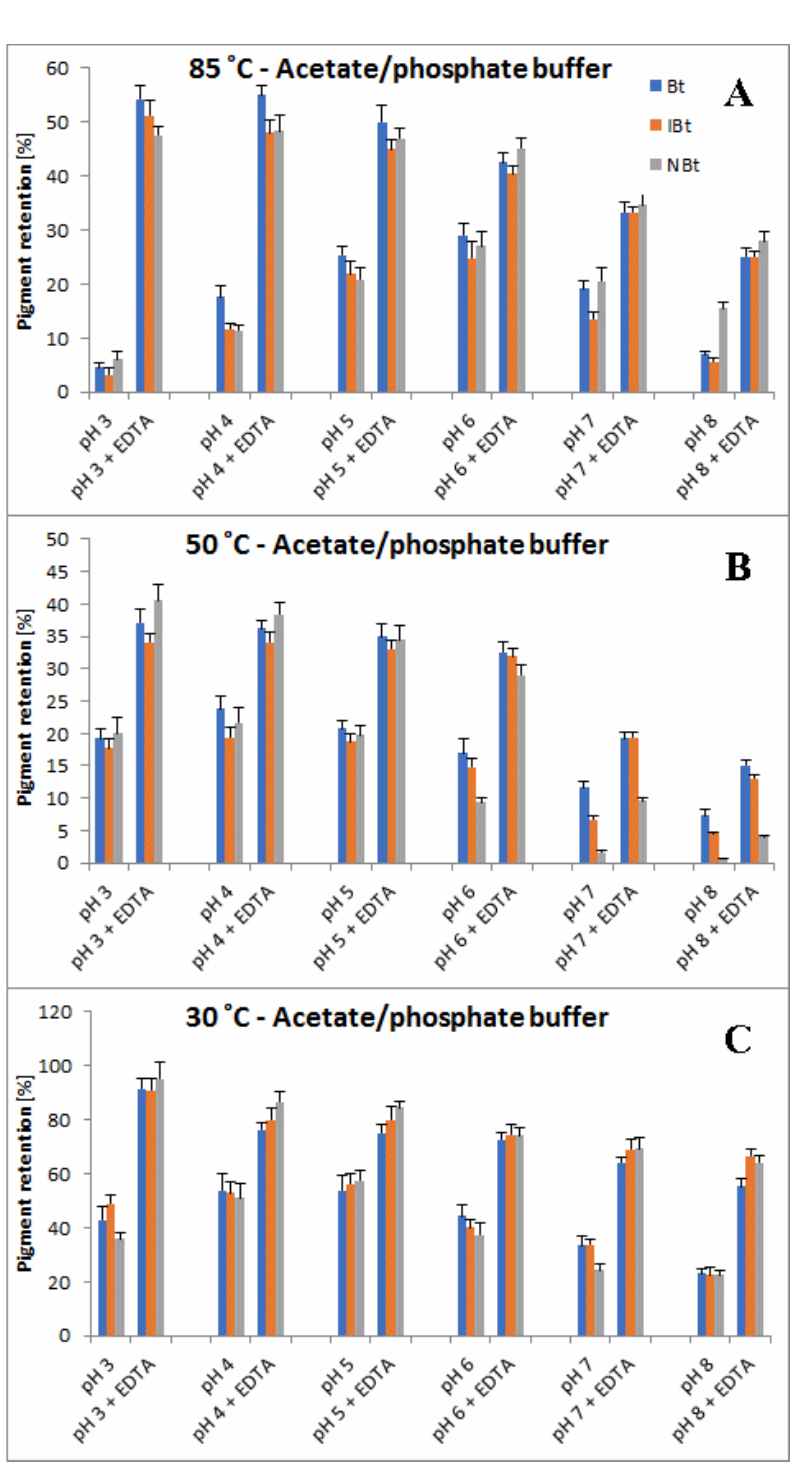
Figure 9. Pigment retention values [%] of betanin 1 , isobetanin 1’ and neobetanin 10 with optional addition of EDTA after long-term heating of the BRE extract for 1 ( A ), 7 ( B ) and 72 h ( C ) in acetate/phosphate at 85, 50 and 30 °C, respectively.